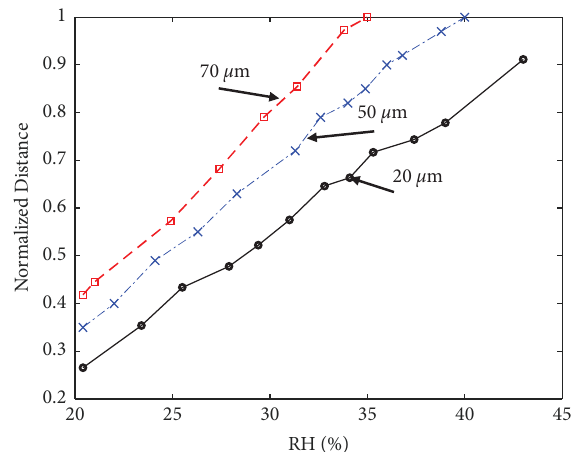
Figure 8: Normalized interference line displacement as a function of relative humidity (%). Te parameter is the gelatin flm